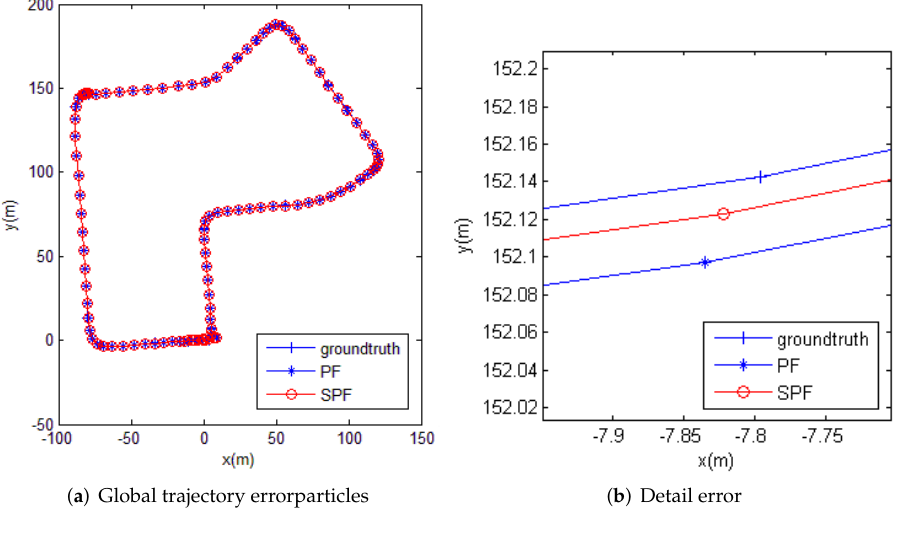
Figure 8. Localization